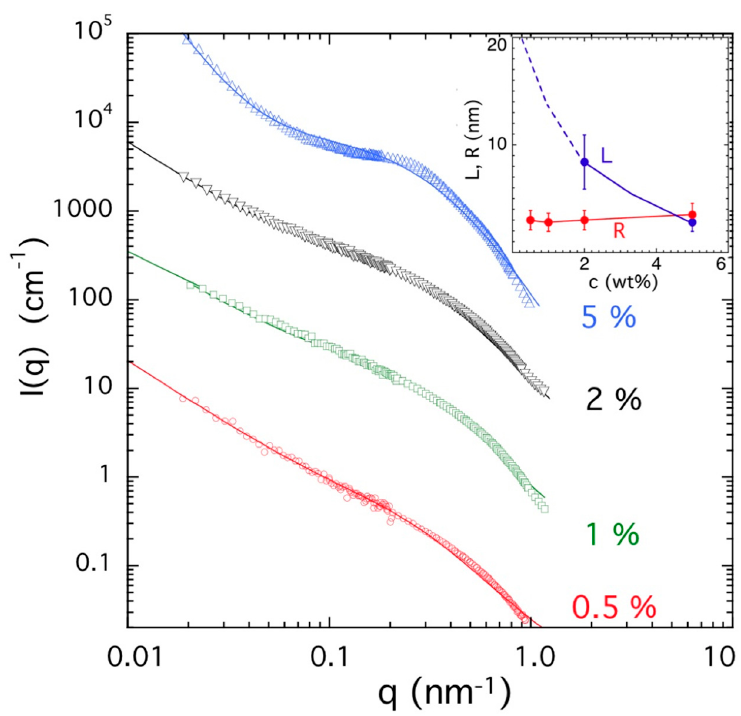
Figure 7. SANS profiles of gelator systems at different concentrations ( T = 25 °C). For clarity, the curves are shifted by a factor of 10 with increasing gelator concentration. The continuous lines through the data points are least squares fits of Equation (1) (0.5 mass % and 1 mass %) and Equation (3) (2 mass % and 5 mass %). The inset shows the variation of R and L with the gelator concentration. Gels 2016 , 2 , 27 Equation (3) again satisfactorily describes the data over the whole temperature range explored.